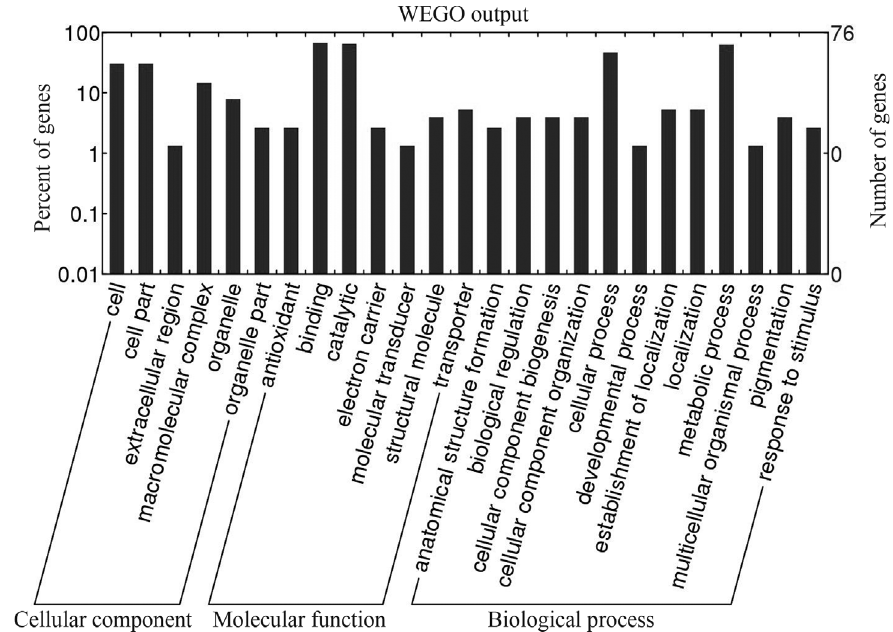
Figure3 -GOclassificationoftheproteinsidentifiedin E.taeniura liver.Theproteinsweregroupedintothreemaincategoriesand25subcategories.The total number of matched GOs corresponding to identified proteins was